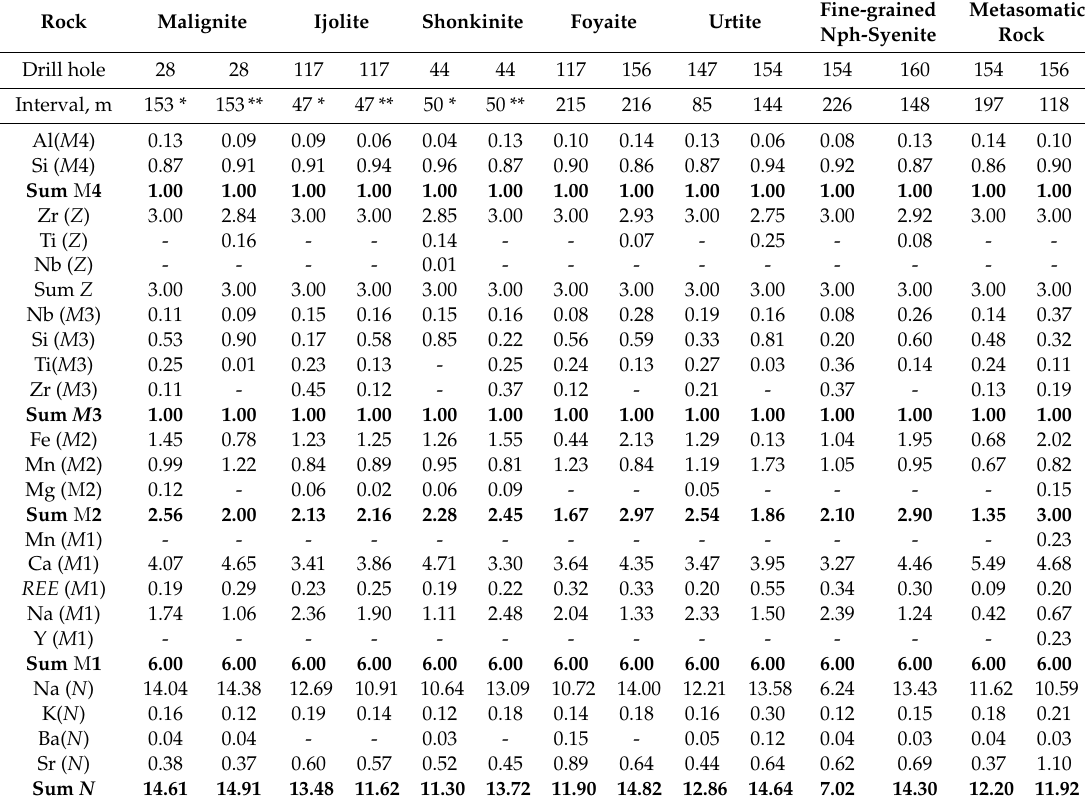
Table 6. Site occupancies of EGM from Table 5, apfu.